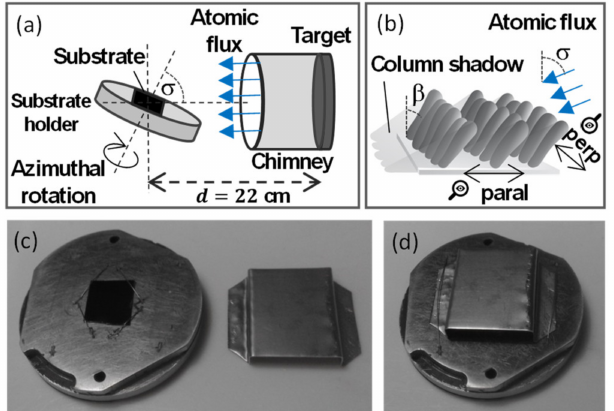
Figure 1. ( a ) Scheme of the sputtering process with glancing angle deposition and possible azimuthal substrate rotation. In this work, the tilt angle, being measured between the sample surface normal and the magnetron source normal, is σ = 85 ◦ . ( b ) Schematic picture of the obtained nanopillars (NPs) with the definition of the directions parallel and perpendicular to the atomic flux. ( c ) Photograph of the sample mounted onto the sample holder and the mask beside them. ( d ) Photograph with the mask placed over the sample, as was used during the fabrication of two of the four